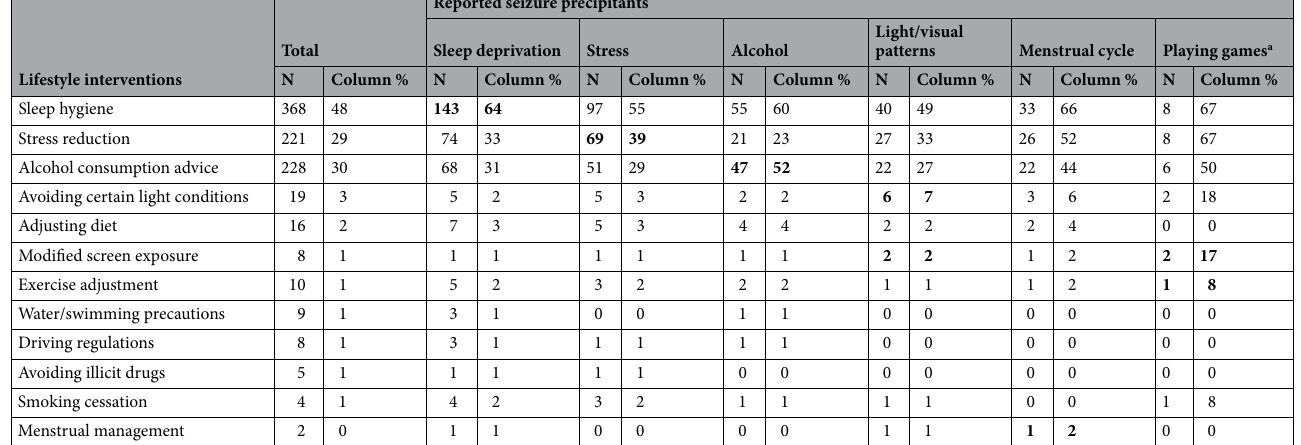
Table 3. Frequency of reported lifestyle interventions tabulated with reported seizure precipitants. Frequency percentages given are the percent of individuals reporting that specific precipitant who are advised of the lifestyle intervention. Frequencies of lifestyle modifications relating to specific triggers are in bold. a Note that this may have been interpreted as either playing physical sports or playing video